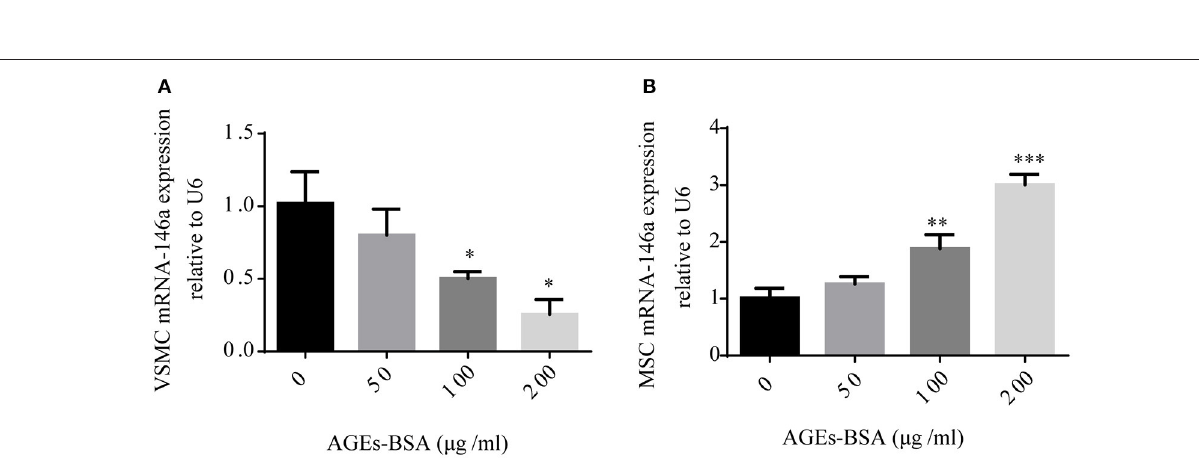
Frontiers in Endocrinology |